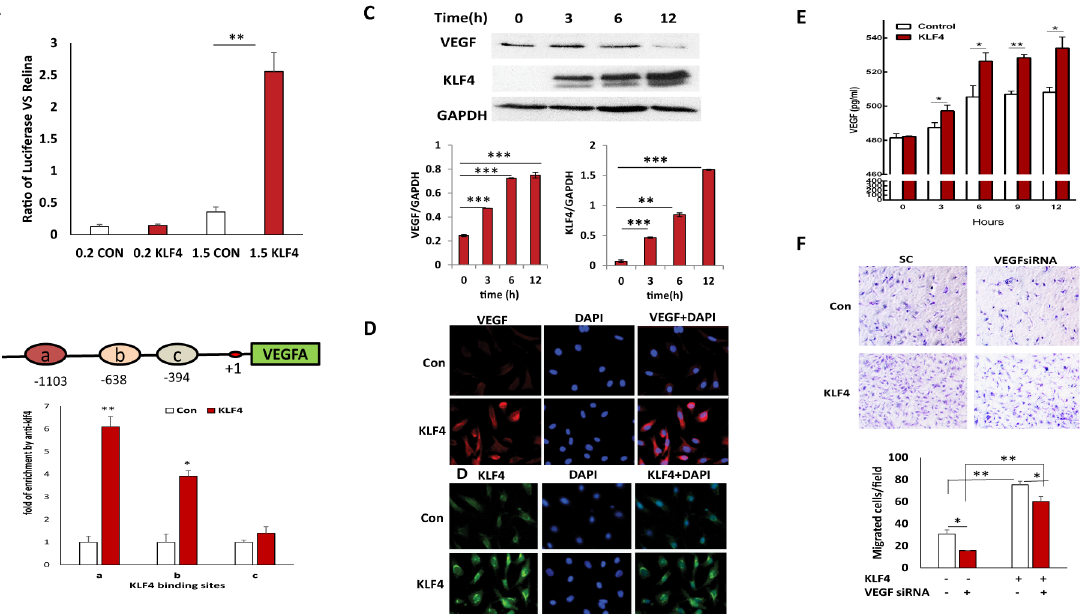
Fig 5. KLF4 transcriptionally activates VEGF expression. A. Luciferase reporter assays were performed to assess KLF4 activation of the VEGF promoter. Luciferase activities in KLF4 expressing and control HRMECs were measured at 24h after transfection with 1.5kb and 0.2kbVEGF promoter luciferase constructs in serum-free conditions. Data were presented as the mean ± SE from three independent experiments. Significance of luciferase activity was found between KLF4 expressing and control cells when 1.5Kb VEGF promoter was transfected in both cells ( ** p < 0.01). B. There are three predicted KLF4 binding sites (CACCC) at the VEGFA promoter. The specific binding sites of KLF4 at the VEGFA promoter was detected by ChIP assay and enrichment of KLF4 binding to sites a and b of VEGFA promoter was significant, not c in KLF4 expressing compared to control cells ( * p < 0.05, ** p < 0.01) C: VEGF expression in HRMECs was detected by Western Blot at different time points. Significance was compared to 0h from 3, 6 and 12h ( * p < 0.05, ** p < 0.01, *** p < 0.001). D: VEGF and KLF4 expression was imaged following immunofluorescence staining at 24h following KLF4 induction. E. VEGF released in cell media was detected using VEGF ELISA assay and significance was observed in KLF4 expressing compared to controls at the indicated time points ( * p < 0.05). F. Cell migration in KLF4 expressing and control HRMECs following VEGF knockdown using VEGF siRNA was examined using transwell migration assay. ( * p < 0.05, ** p <